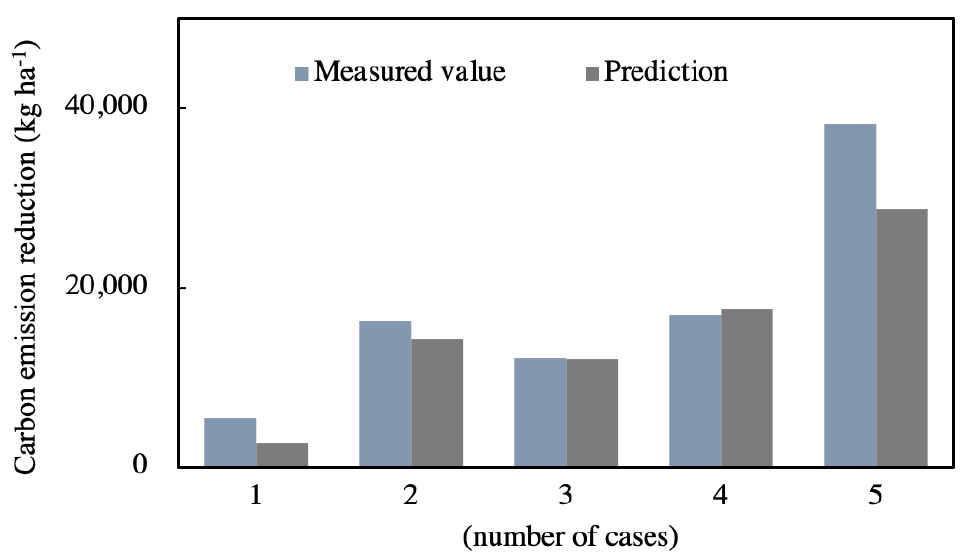
Figure 3. Measured and predicted values of carbon emission reduction from paddy soils under biochar incorporation.